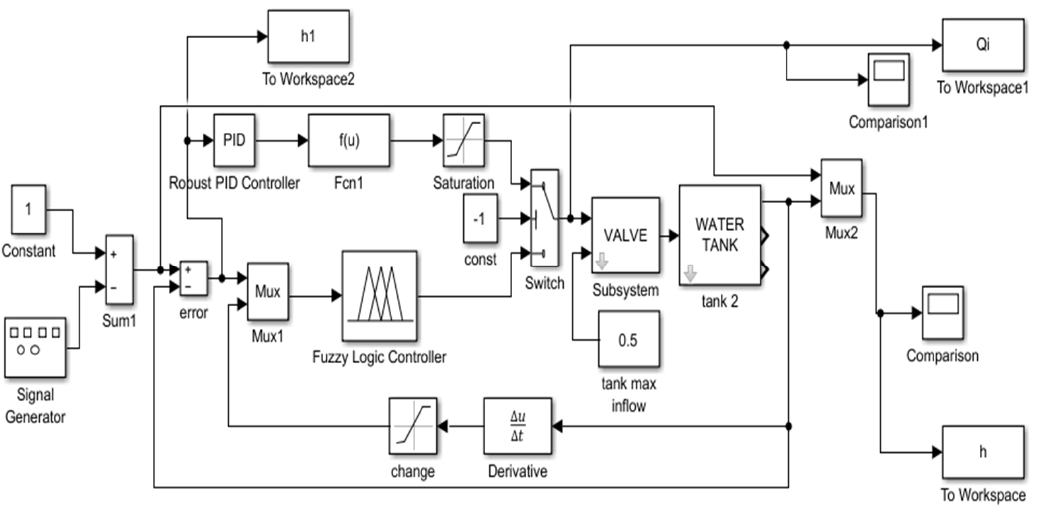
Figure 5. Simulation diagram of fuzzy controller and nonlinear robust controller decorated by S function.